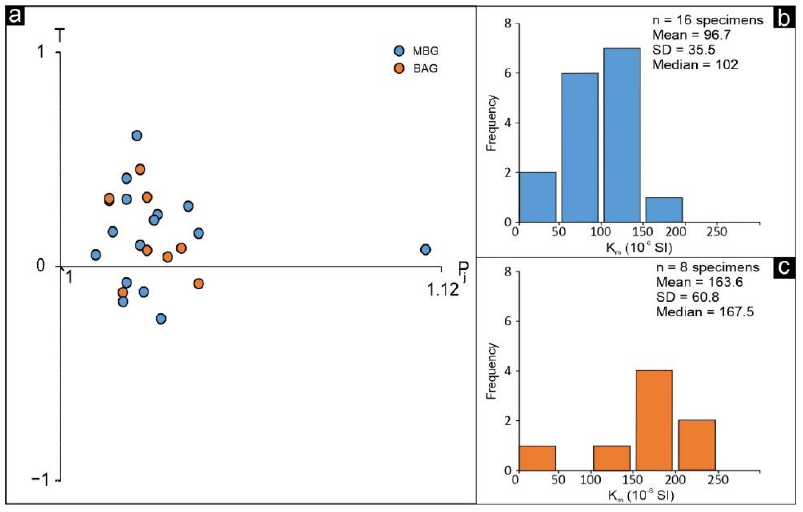
Figure 6. Magnetic parameters for the investigated granitoids from the upper crustal levels of the Serre Batholith: ( a ) Degree of magnetic anisotropy (P j ) vs. shape parameter (T) plot (Jelínek plot); (b)-(c) histograms of K m reporting variation of magnetic susceptibility values within MBG ( b ) and BAG ( c ), the latter having higher mean magnetic susceptibility. Blue: MBG; orange: BAG. SD: standard deviation.